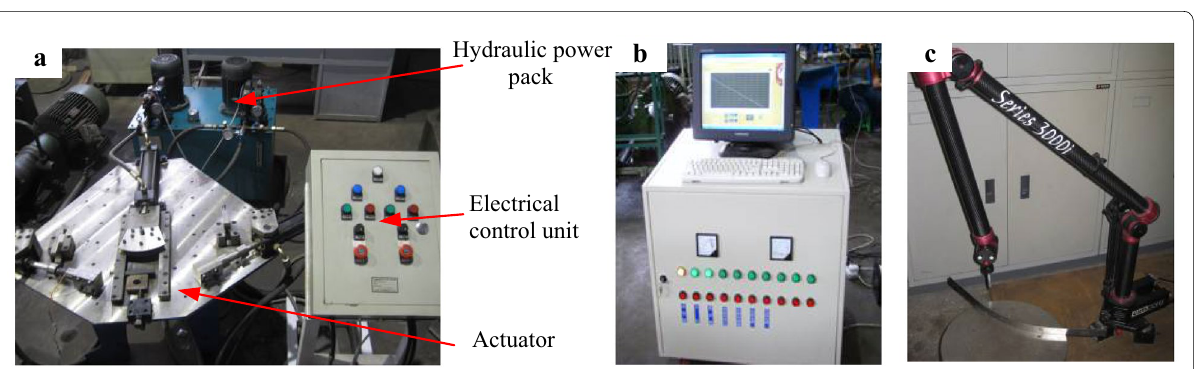
Figure 10 Experimental system of curvature iterative compensation for stretch-bending process: a stretch-bending testing machine, b signal monitoring equipment, c CMM